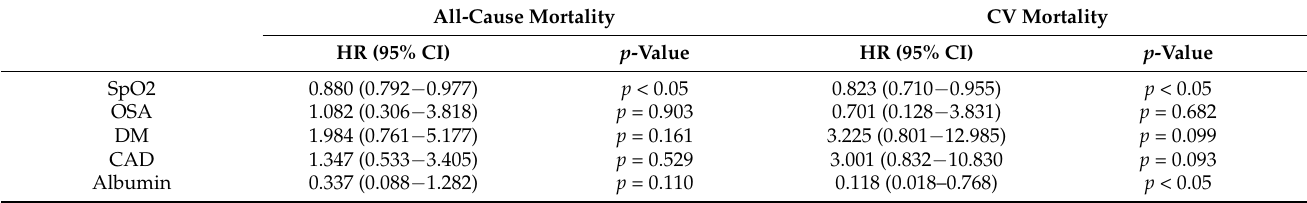
Table 5. Multivariable Cox regression model for all-cause and CV mortality with respect to potential prognostic factors.